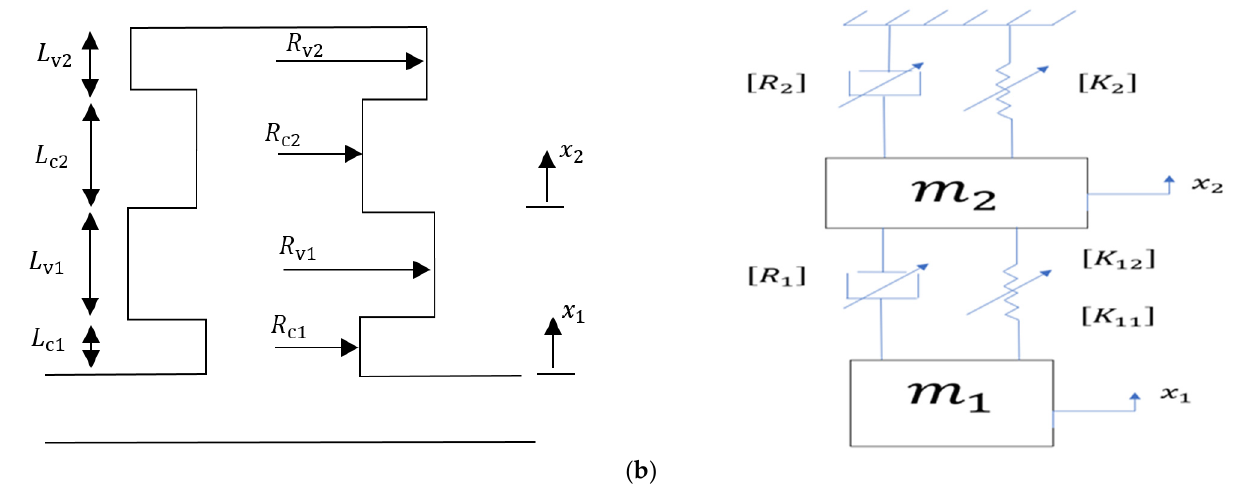
Figure 1. ( a ) The dual nonlinear HR, and ( b ) its equivalent lumped-parameter system.